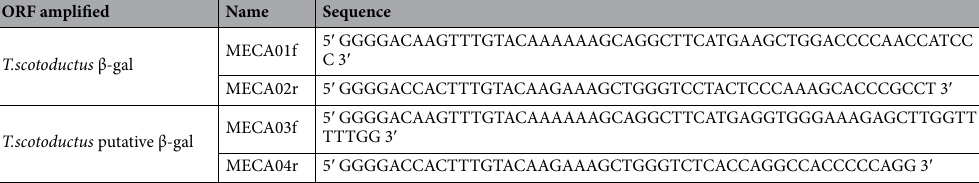
Table 4. Primers used for the amplification of T. scotoductus β-galactosidase and putative β-galactosidase